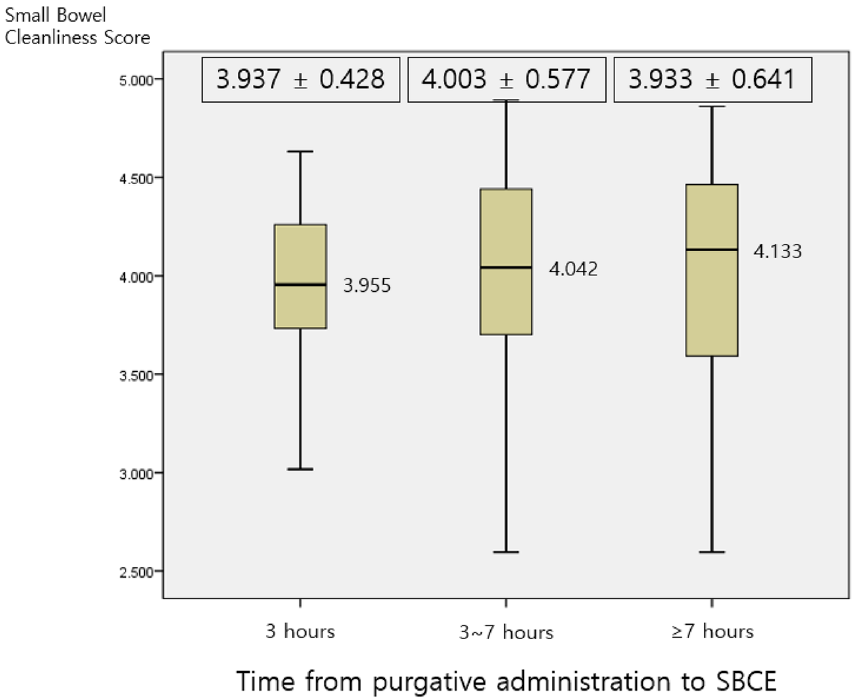
Figure 2. Relationship between small bowel cleanliness score and time from the last dose of purgative administration to small bowel capsule endoscopy (SBCE). The time from the last dose of purgative administration to SBCE was divided into 3 h and 7 h intervals. There was no significant difference between the three groups (p =